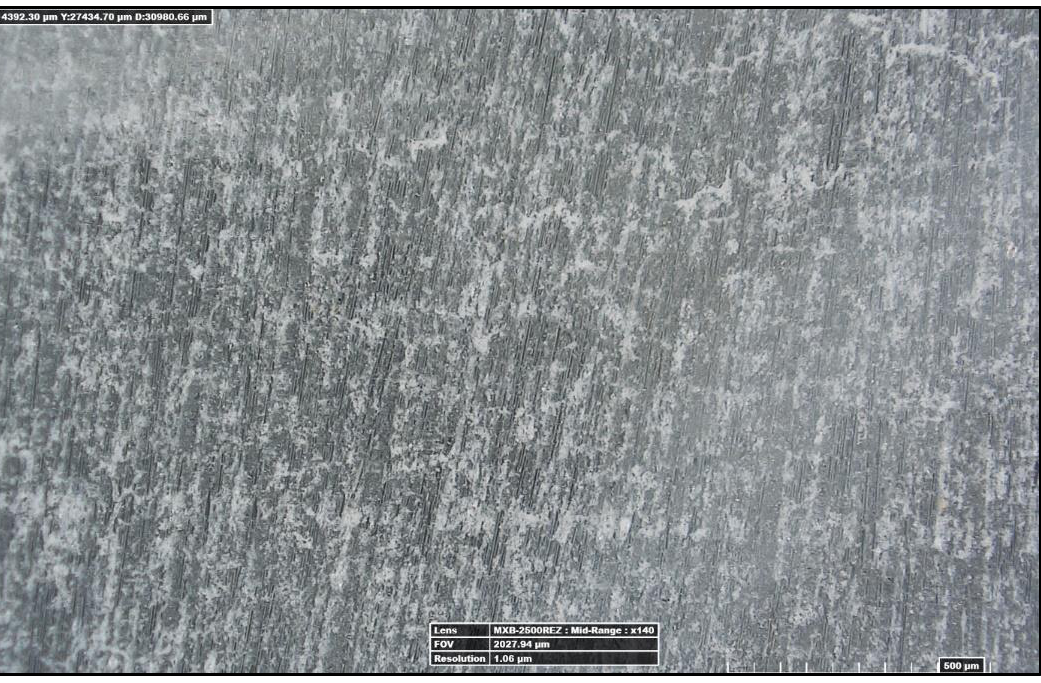
Figure 5. R-glass FRP plate with a ( bottom ; ×350 magnification) transverse and ( top ; ×350 magnification) hoop fiber orientation after a week of exposure to pH 4.0 aqueous solution.